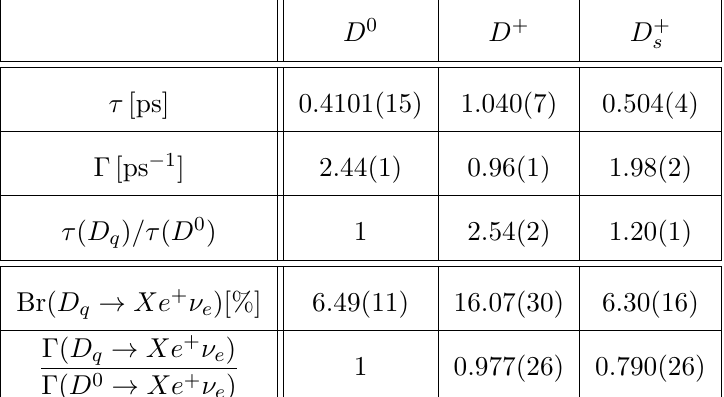
(cid:8) (cid:9) ). All values are taken from D 0 , D + , D + q ∈ s